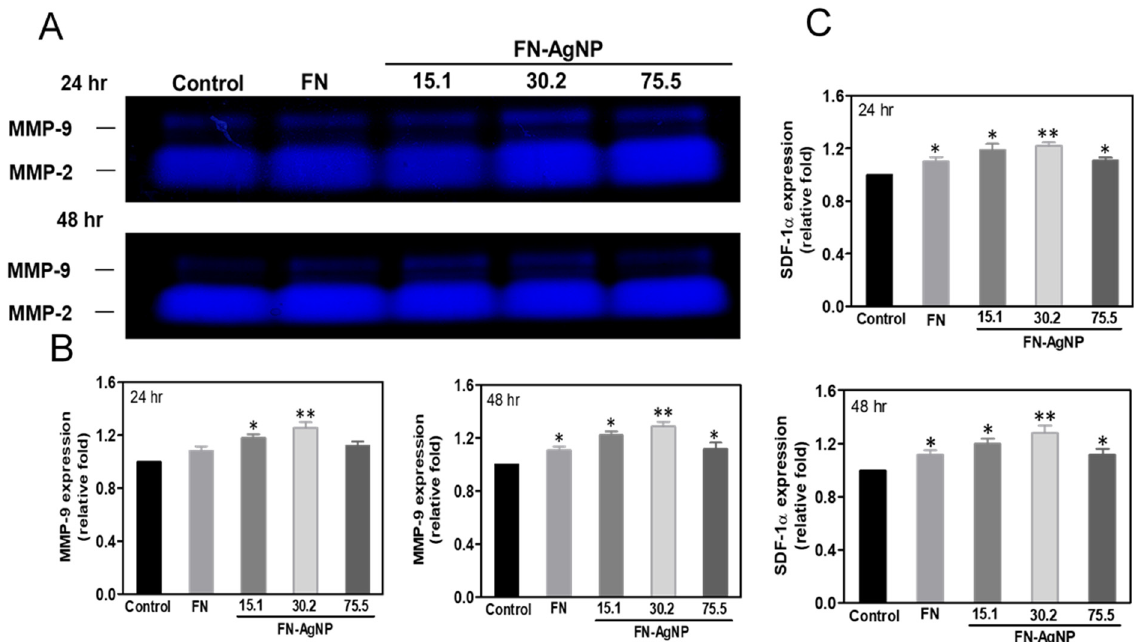
Figure 4. The MMP enzymatic activities and SDF-1 α protein expression in MSCs culturing on various materials at 24 and 48 h. ( A ) The representative MMP-2 and MMP-9 zymogram for (a) 24 and (b) 48 h is shown. The semiquantitative meas-urement of ( B ) MMP-9 and ( C ) SDF-1 α protein expression revealed a significantly greater expression culturing MSCs with FN-AgNP 30.2 ppm at 24 and 48 h. Data are presented as mean ± SD ( n = 3). * p < 0.05; ** p < 0.01: greater than the control. Control group = glass cover slide.